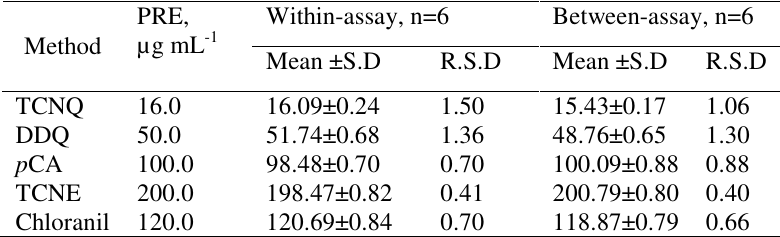
Table 3. Precision of the proposed methods for analysis of pregabalin